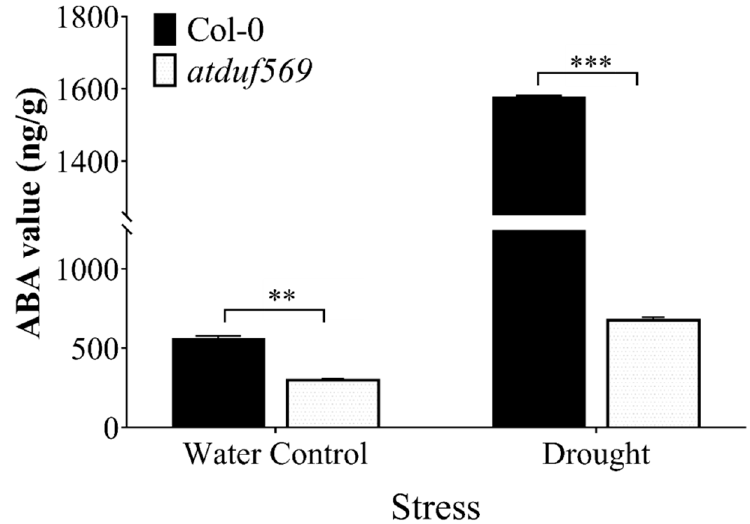
Figure 9. Change in abscisic acid ABA content of WTCol-0 and atduf569 Arabidopsis plants under drought conditions. Data represent means of values obtained from experiments performed in triplicate. Error bars represent standard deviation. Means were analyzed for significant differences using Student’s t -test. Asterisks * indicate significant whereas “ns” indicate non-significant differences at 5% level of significance (*** p < 0.001, ** p < 0.01).